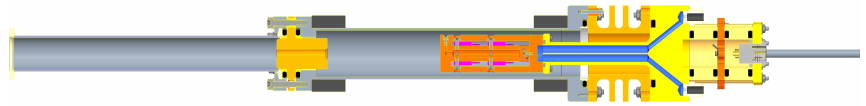
Figure 4. Extended target chamber with the side view of beam calorimeter are shown. Two blue pipes at the right side of the figure are for water cooling of